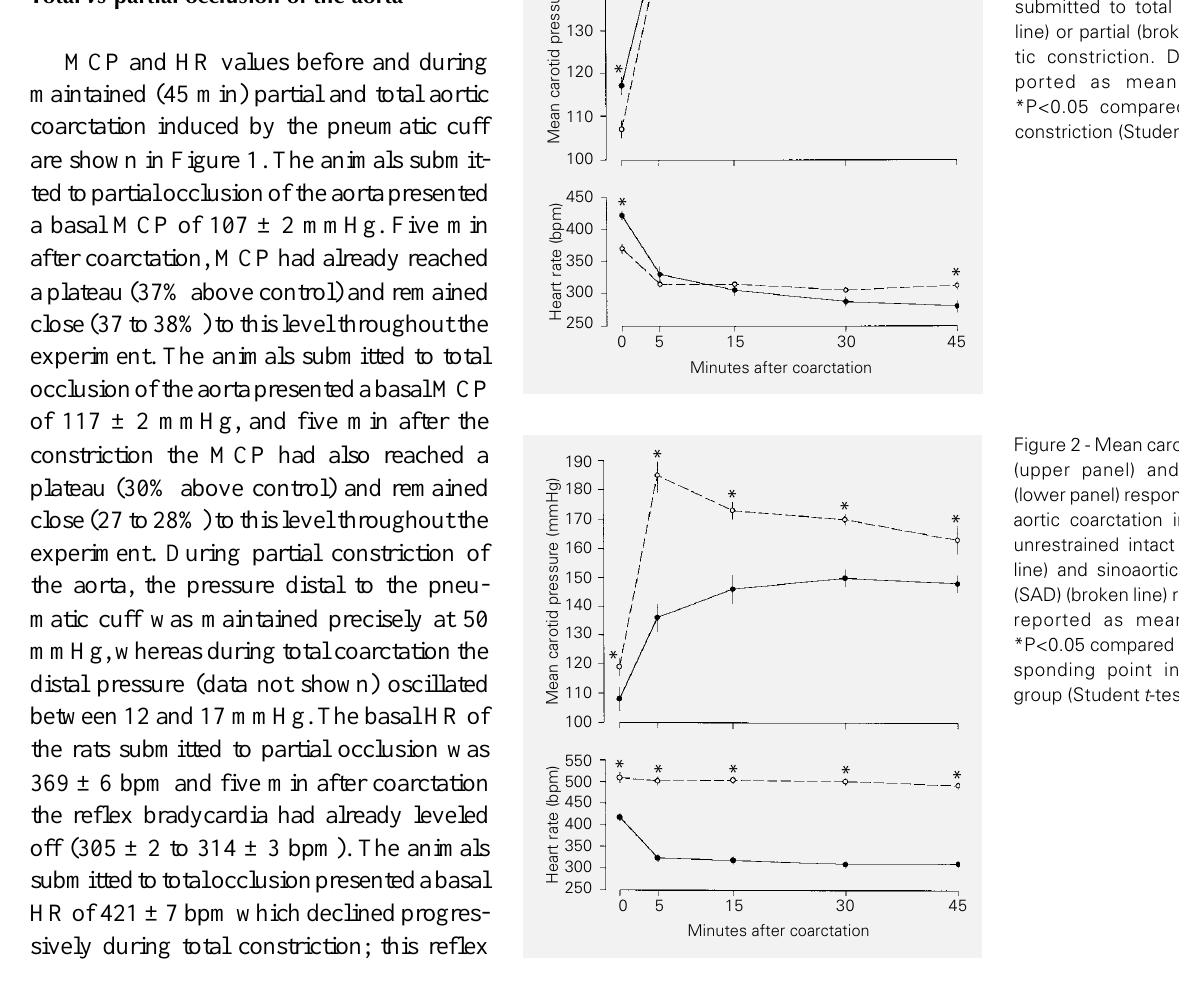
Figure 1 - Mean carotid pres- sure (upper panel) and heart rate (lower panel) responses to acute aortic coarctation in con- scious unrestrained intact rats submitted to total (continuous line) or partial (broken line) aor- tic constriction. Data are re- ported as means ± SEM. *P<0.05 compared to partial constriction (Student t -test). M e